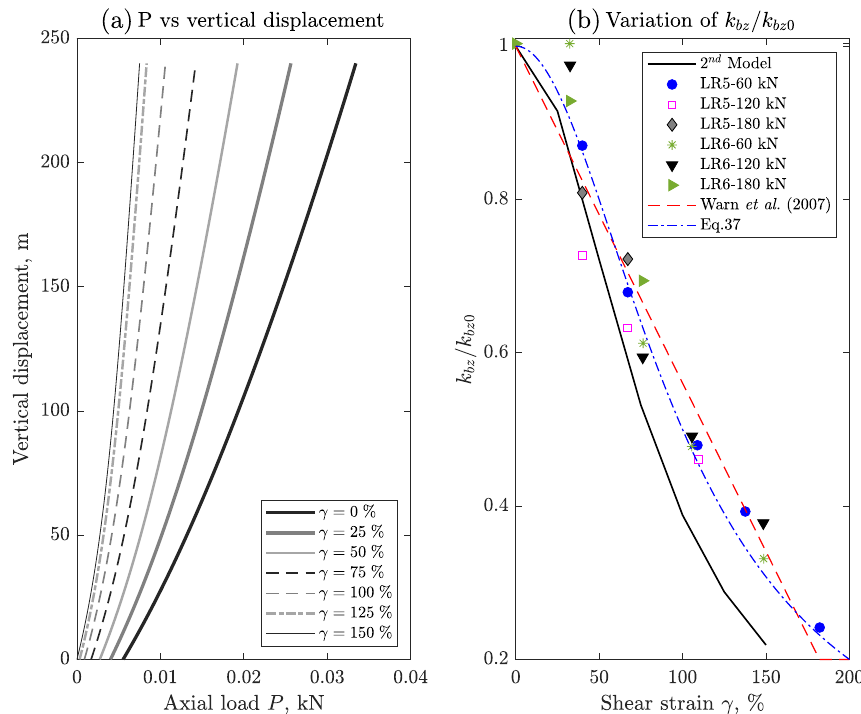
Fig. 12 Axial load versus vertical displacement curves and variation of normalized vertical stiffness with shear